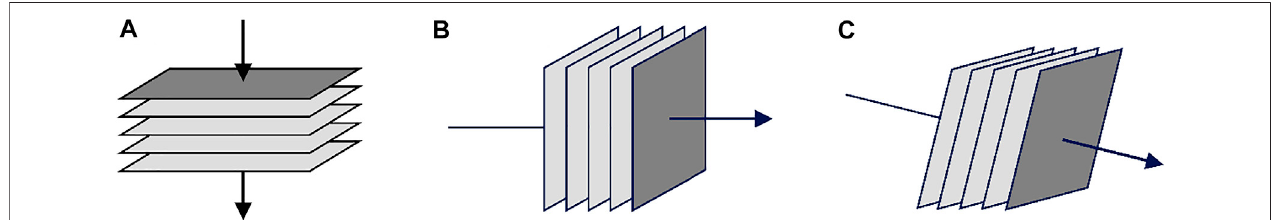
West trending reverse fault. Well B1-B5 are all located in the upper wall of the fault. The curvature attribute can better identify secondary faults. The red area in Figure 5B represents the curvature attribute ’ s high-value area, representing the